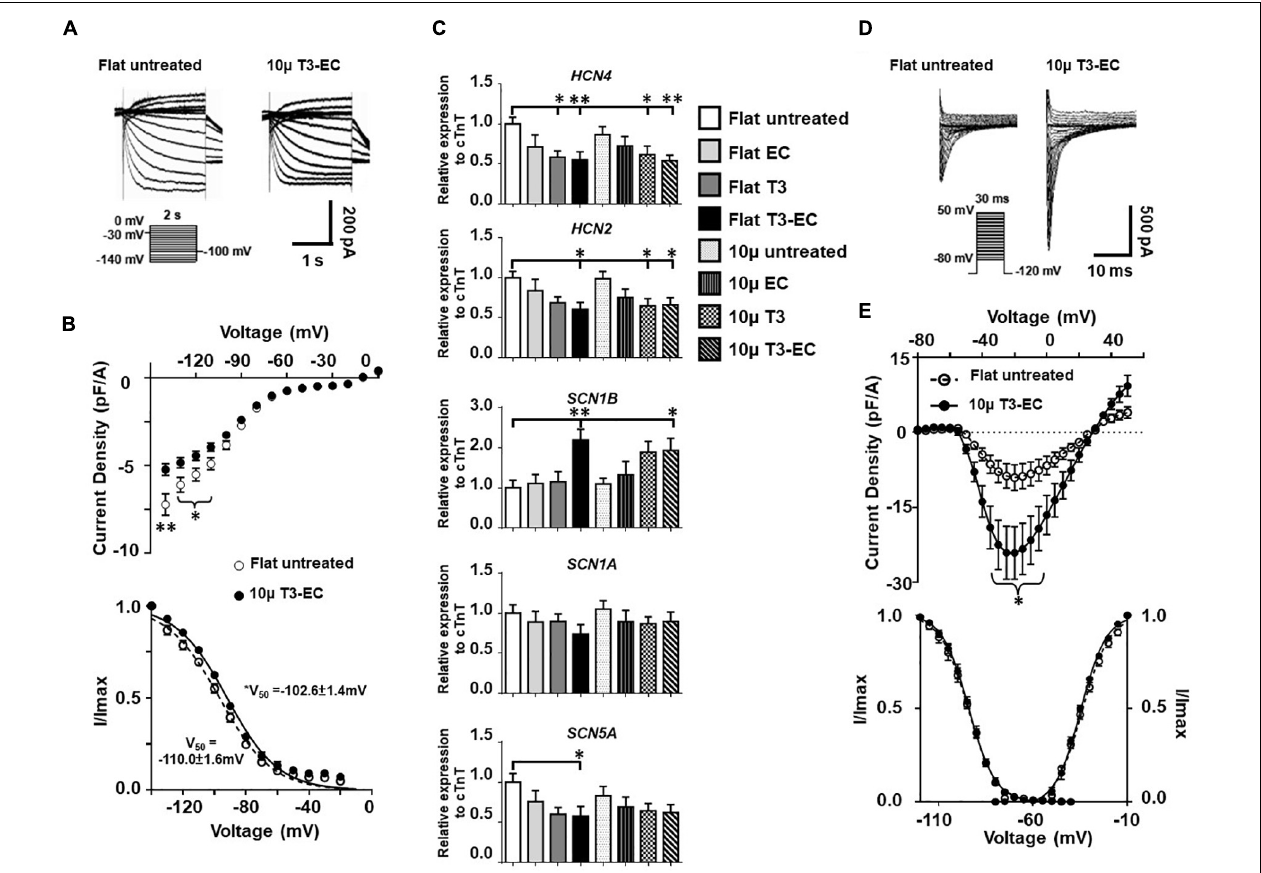
FIGURE 3 | M-T3-EC decreases funny current by downregulating HCN2/4 expression and increases inward sodium current by upregulating SCN1B expression in hvCAS. (A) Representative I f traces in the presence of 1mM Ba 2 + of flat untreated and 10 µ T3-EC hvCAS. (B) The steady-state I–V and steady-state activation relations of I f from flat untreated and 10 µ T3-EC groups (three batches of independent differentiations; n = 16–21). (C) mRNA expression level of HCN4, HCN2, SCN1B, SCN1A, and SCN5A (11 batches of independent differentiations, n = 11). (D) Representative I Na traces of flat untreated and 10 µ T3-EC hvCAS. (E) The peak I Na density I–V plots, steady-state activation (G/Gmax), and inactivation (I/Imax) relationships of flat untreated and 10 µ T3-EC groups (peak I Na density I–V plots and steady-state activation: three batches of independent differentiations, n = 9–11; inactivation: two batches, n = 5–7). (B,E) Two-tailed unpaired t -test. (C) One-way ANOVA test followed by Dunnett multiple comparison test to flat untreated control. ∗ p < 0.05 and ∗∗ p < 0.01.